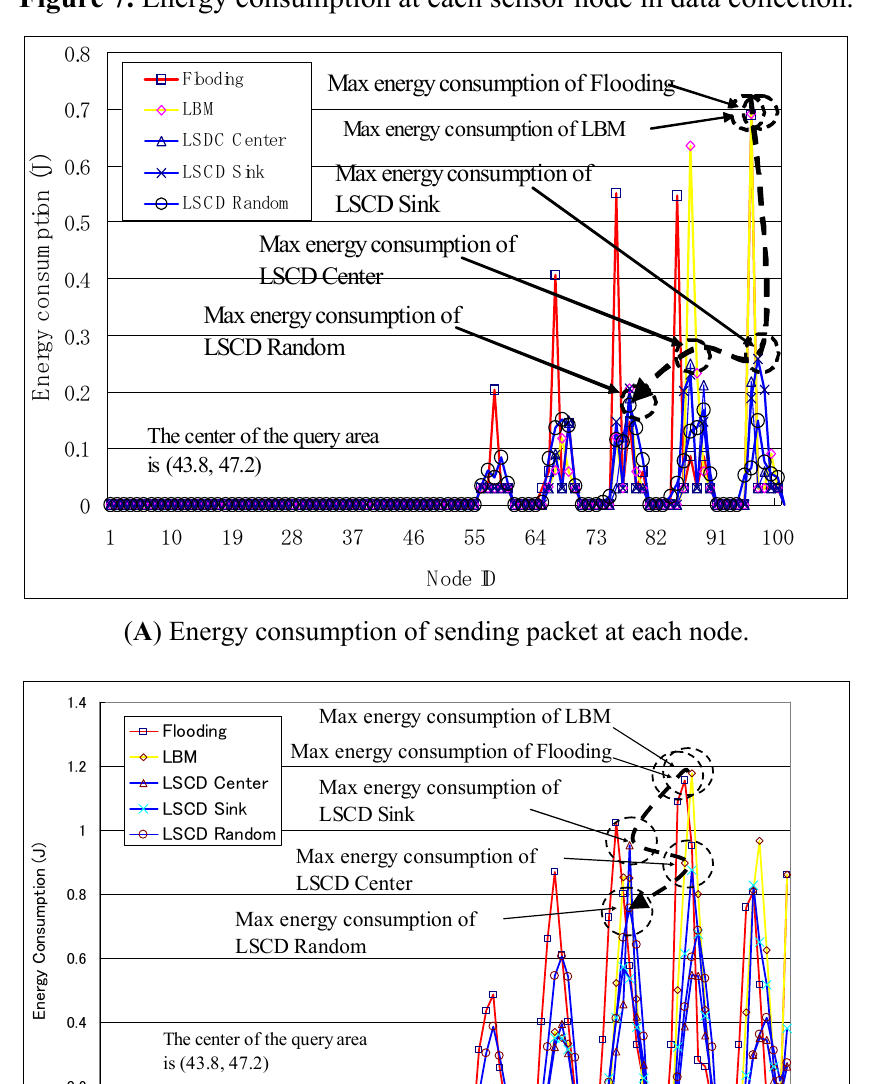
Figure 7. Energy consumption at each sensor node in data